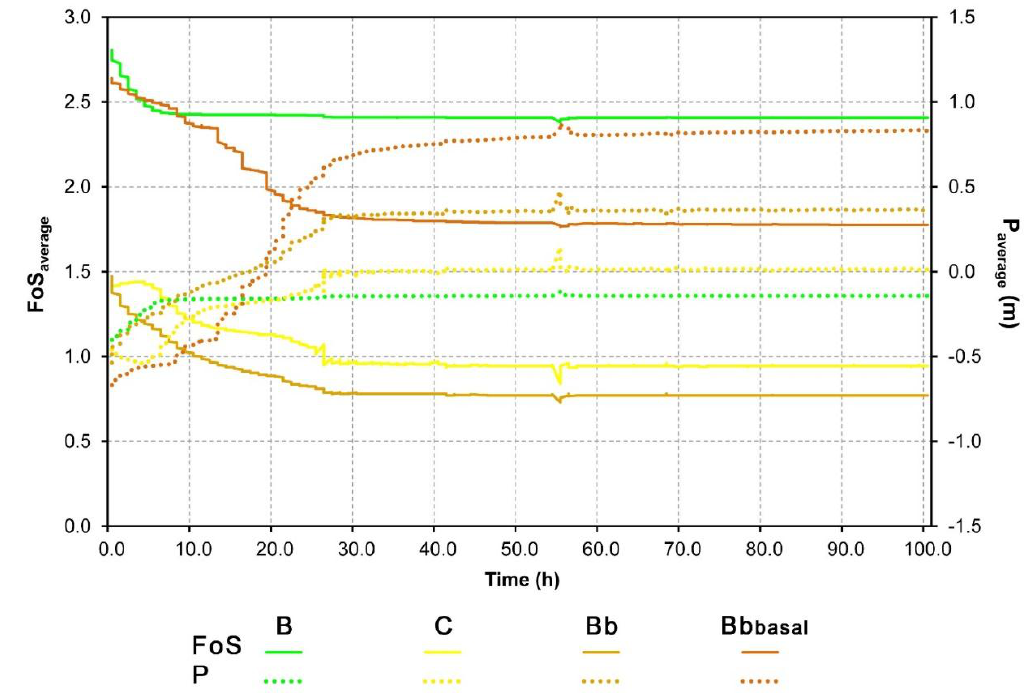
Figure 8. Example of the factor of safety (FoS) and soil pressure head (P) time series simulated for each soil horizon for the 40° slope model of the Sarno Mountains under a constant rainfall intensity of 20 mm/h and winter antecedent hydrological conditions.